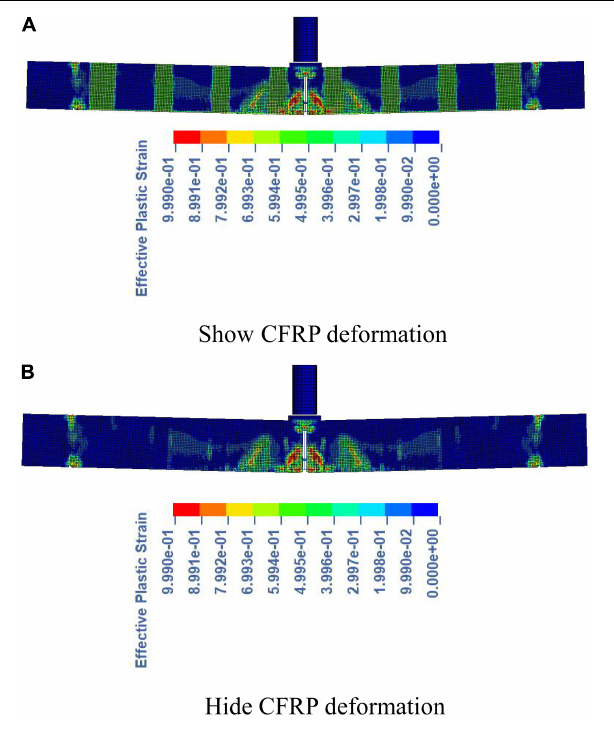
the impact load is weakened. And because the damage is concentrated in the mid-span, except for the U-shaped strips and the bottom strips on both sides of the impact point, the remaining U-shaped strips are more difficult to fully exert their resistance at higher impact